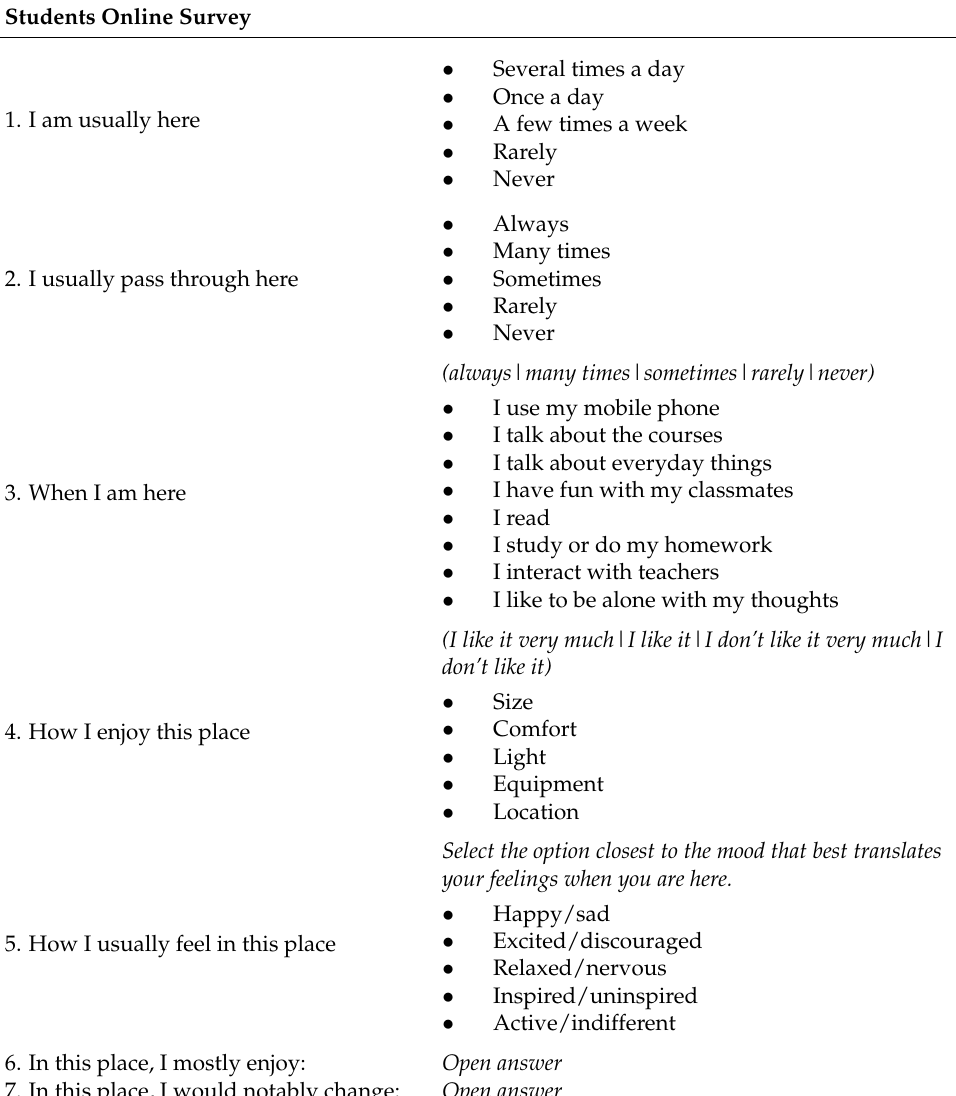
Table 2. List of questions for the questionnaire. Students Online